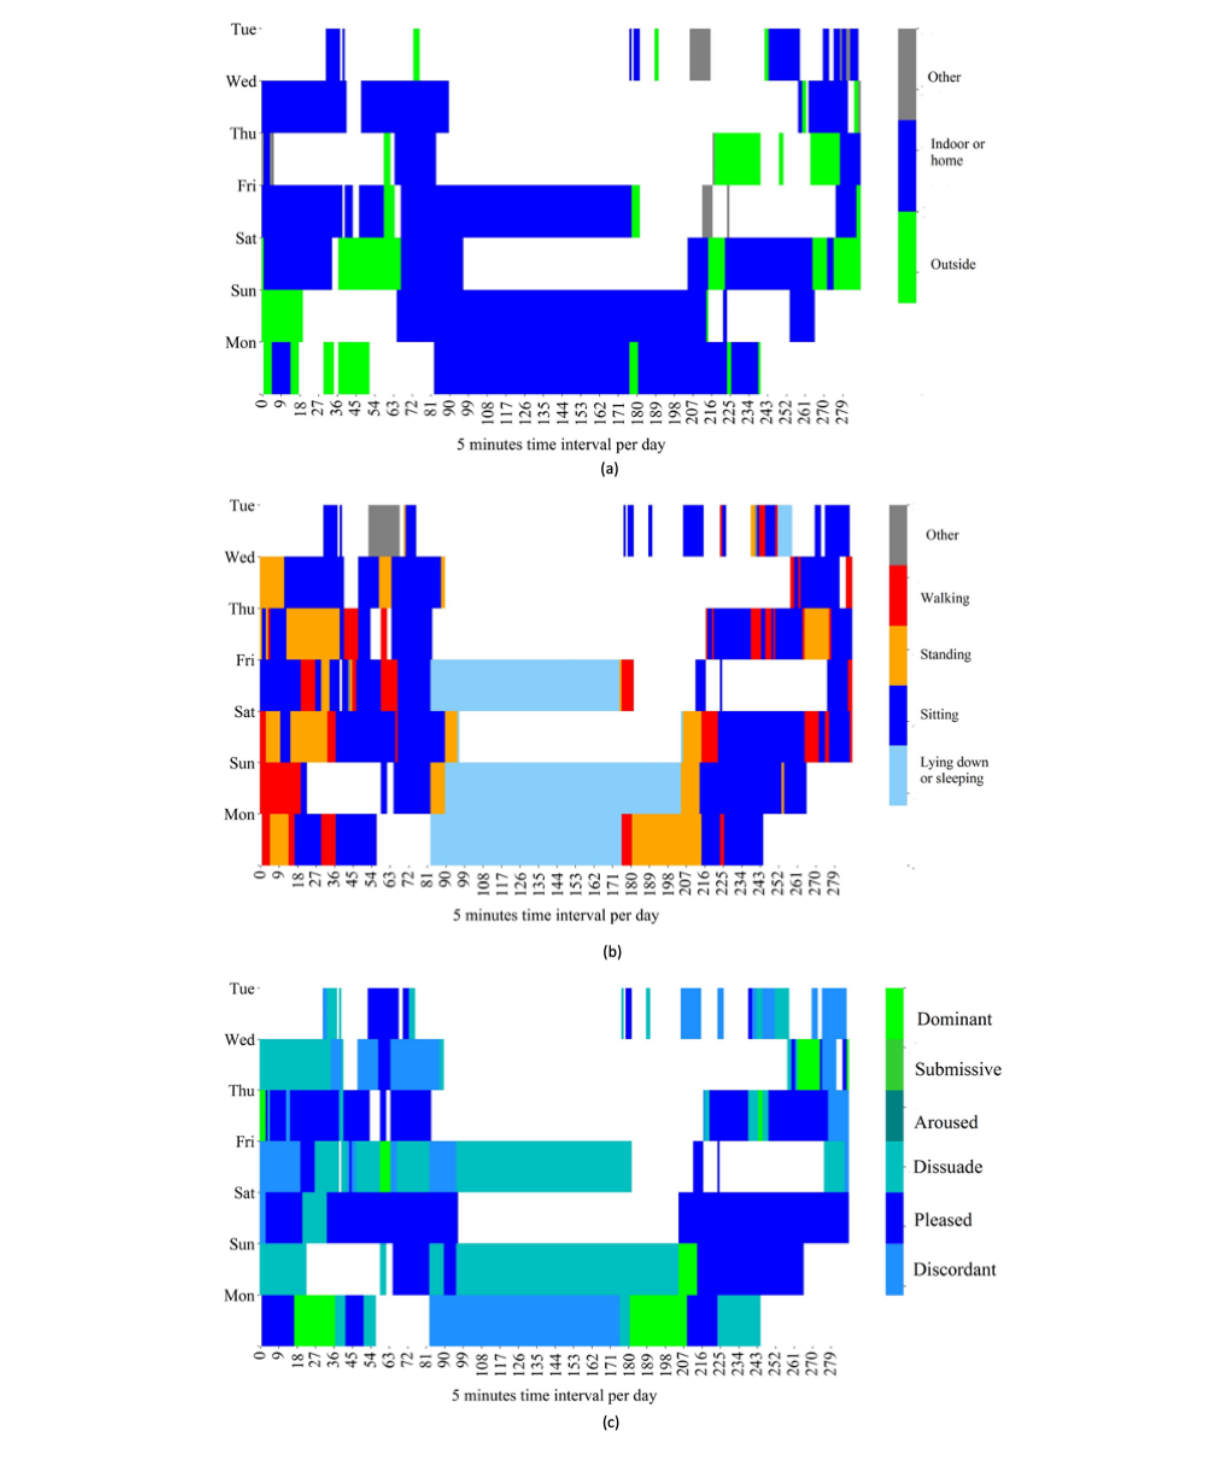
Figure 9. Daily life versus emotional states of person 14 (average case). The x-axis plots 288 windows per day, and the y-axis plots the number of days in the data collection period of person 9. The color-coded regions represent (a) spatial contexts, (b) activities, and (c) emotional states in each window over the period of data collection (7 days). The white regions represent missing